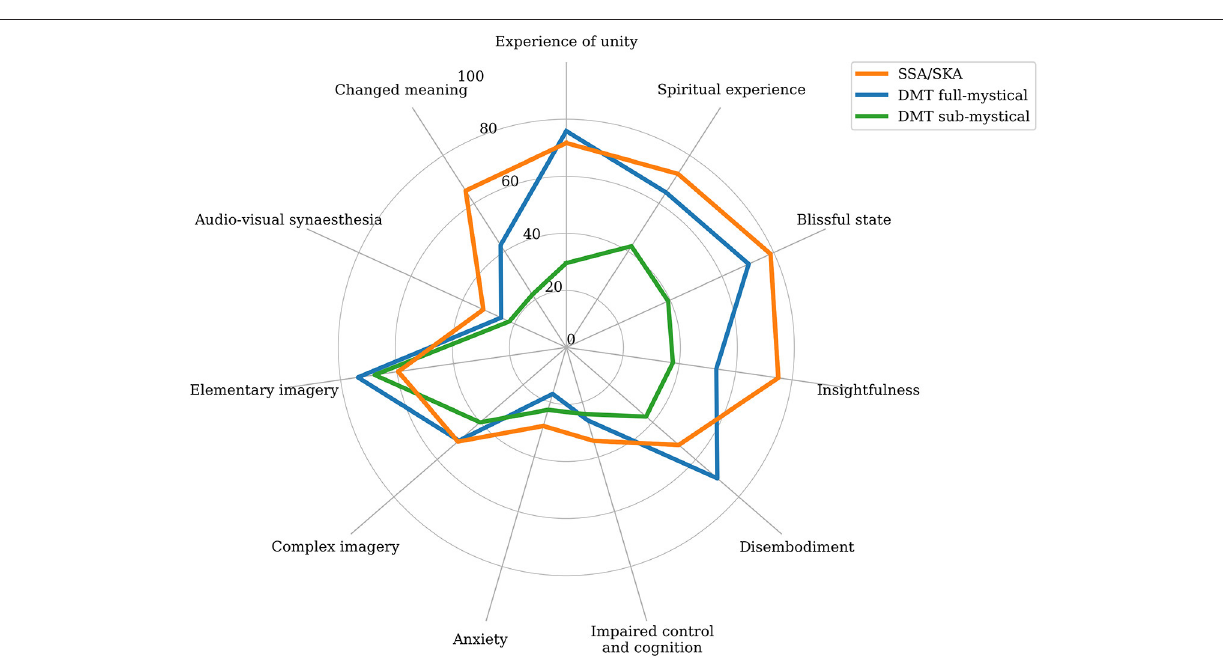
Frontiers in Psychology |